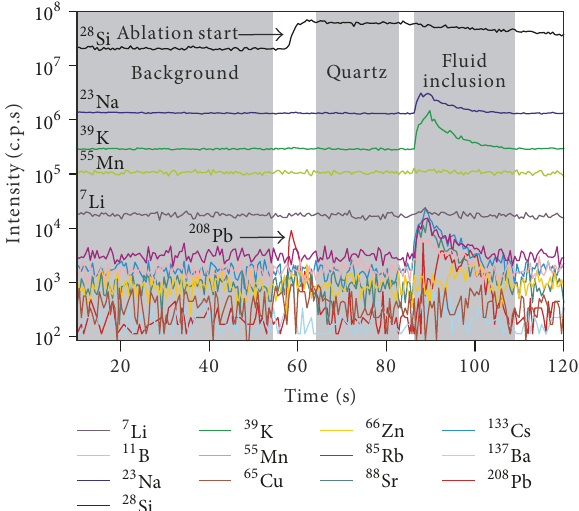
Figure 4: Time-resolved ICP-MS signal of a H 2 O-CO 2 fluid inclusions in stage I quartz. This fluid inclusion is 20 × 12 𝜇 m in size and 5 𝜇 m below sample surface. Note a distinct Pb peak caused by surface contamination (sample polishing material contains Pb) at the beginning of ablation, but it is easy to separate this Pb peak from the Pb peak generated by the fluid inclusion. “Background,” “quartz,” and “fluid inclusion” refer to the respective signal intervals used for